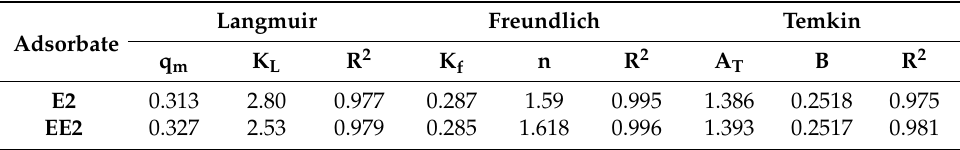
Table 3. Isotherm model constants and correction coefficients.